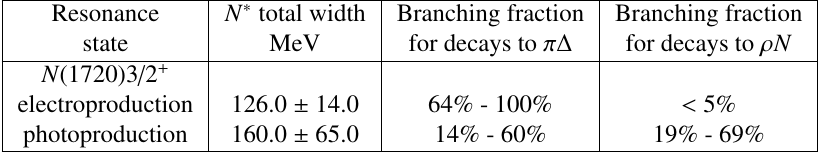
Table 5. N (1720)3 / 2 + hadronic decays determined from the independent fits to the data on charged double pion photo- [17] and electroproduction [23] o ff protons accounting only for contributions from conventional